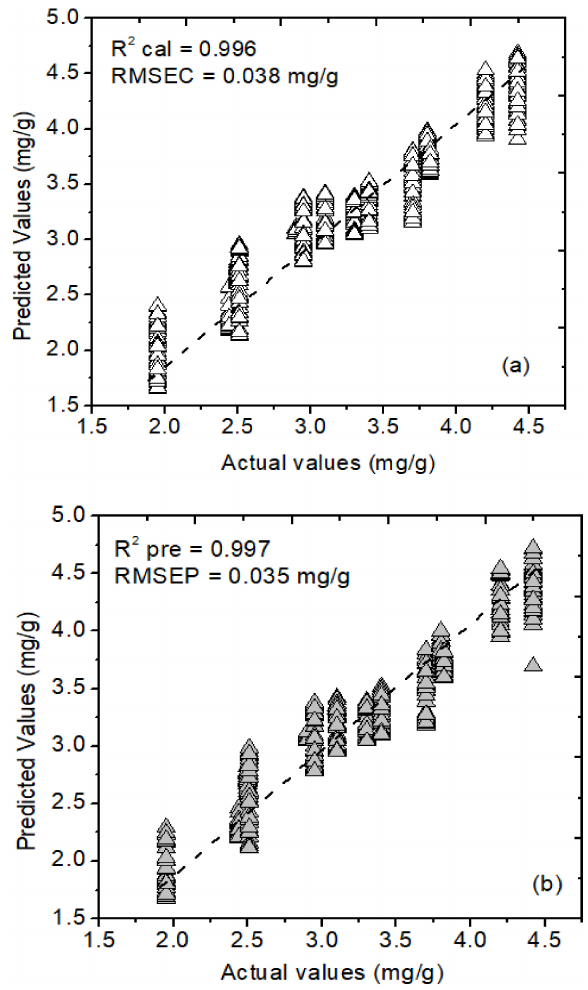
Figure 5. PLSR graphs of actual versus predicted concentration for the phenolic compounds in moringa powder for the calibration ( a ) and prediction ( b ) datasets. RMSEC and RMSEP represent the root mean square error of calibration and